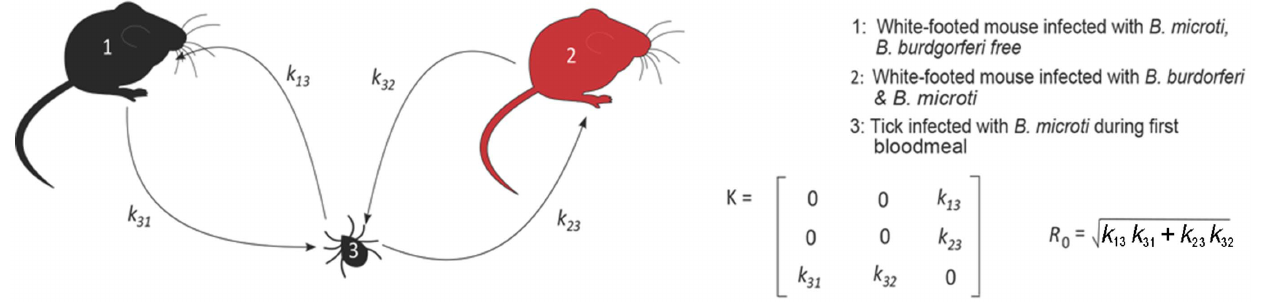
Fig 2. The transmission graph for Babesia microti for singly infected and coinfected mice. Three ‘host types’ are defined: (1) Peromyscus leucopus mouse, Borrelia burgdorferi free, infected with B. microti , (2) P. leucopus mouse infected with B. burgdorferi and B. microti and (3) tick infected with B. microti during first blood meal. The transmission graph is used in the construction of the next-generation matrix ( K ) for R 0 where k ij indicates the expected number of host type i infected by host type j